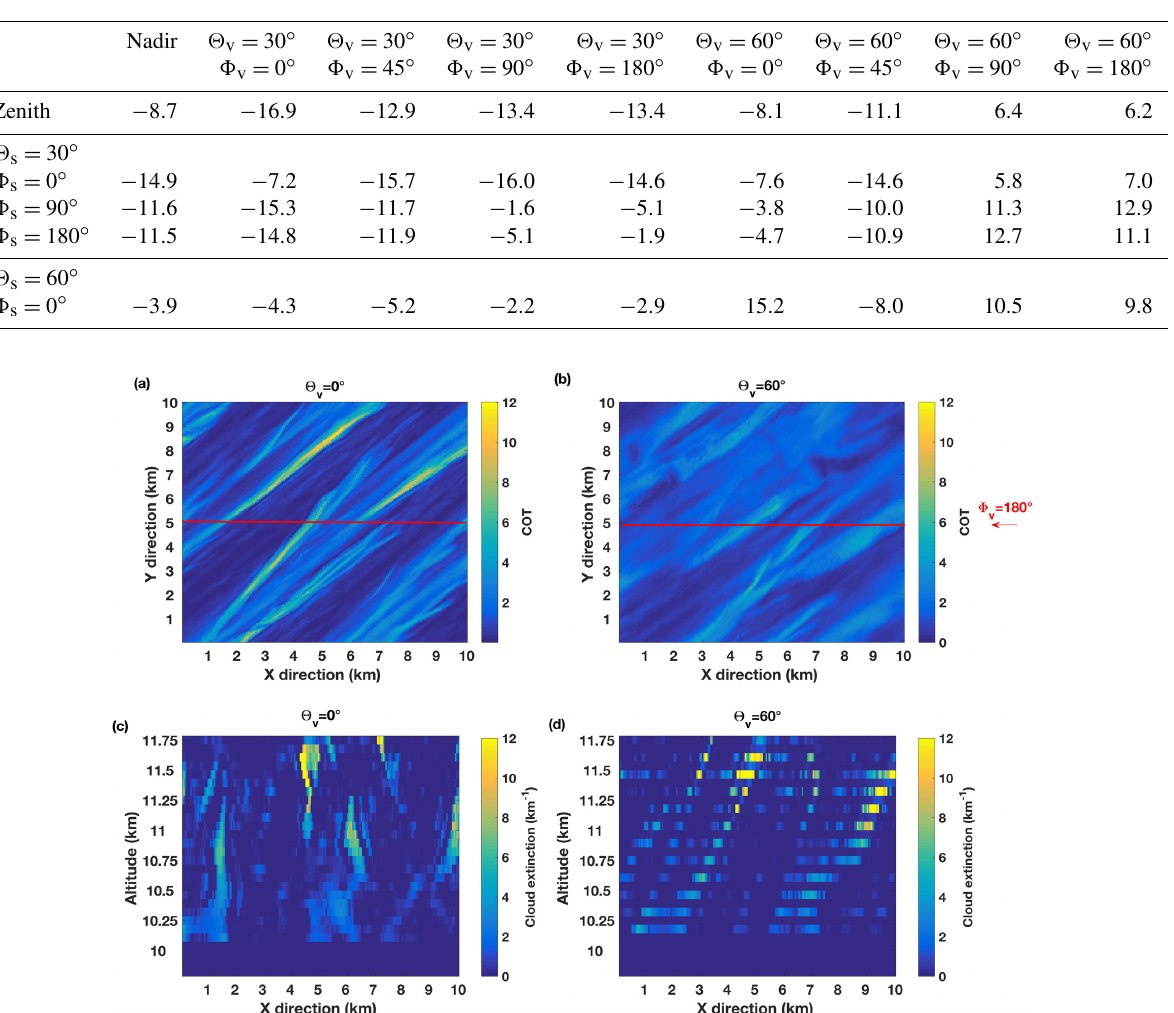
Figure 12. Optical thickness (COT) field of view from nadir (a) and from a view zenith angle (cid:50) v = 60 ◦ (b) , and vertical profile of the cloud extinction coefficient view from nadir (c) and from (cid:50) v = 60 ◦ (d) along the red line of the COT field in (a, b) for a viewing azimuth angle (cid:56) v = 180 ◦